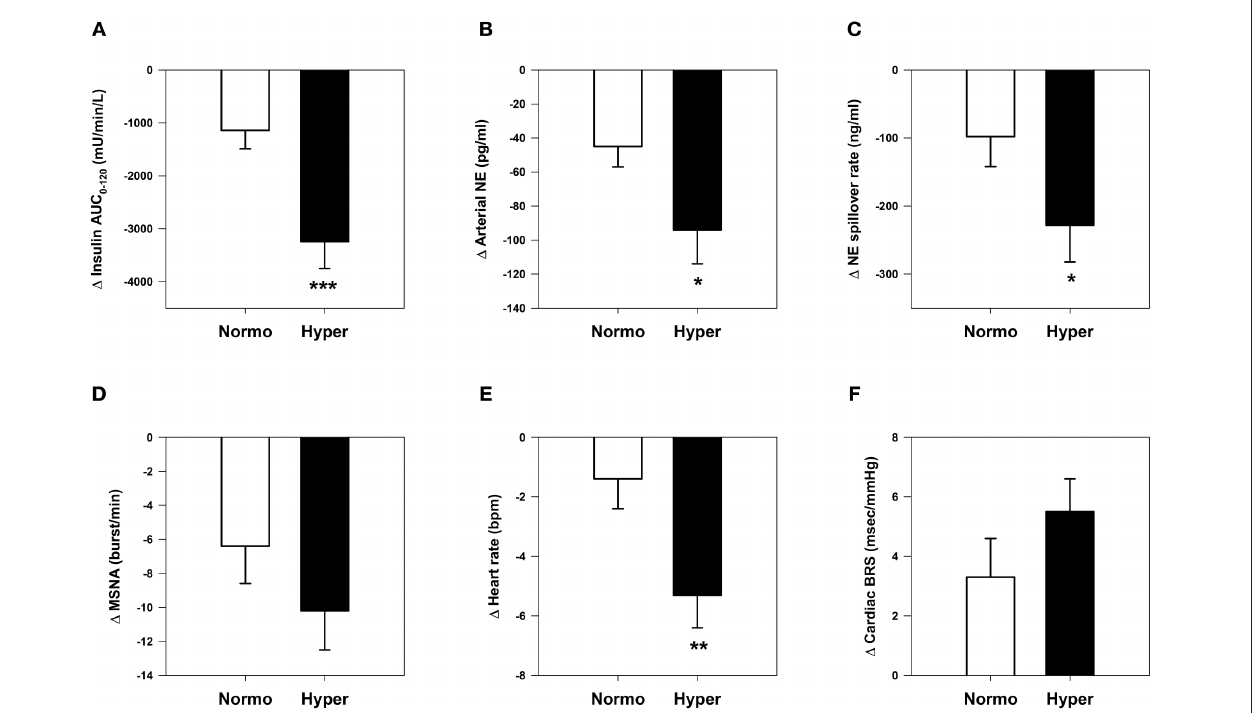
FIGURE 3 | Comparative changes in sympathetic neural and cardiovascular parameters in normoinsulinemic and hyperinsulinemic subjects. (A) Insulin area under the curve (AUC) during oral glucose tolerance test. (B) Arterial plasma norepinephrine (NE) concentration. (C) Whole-body NE spillover rate. (D) Muscle